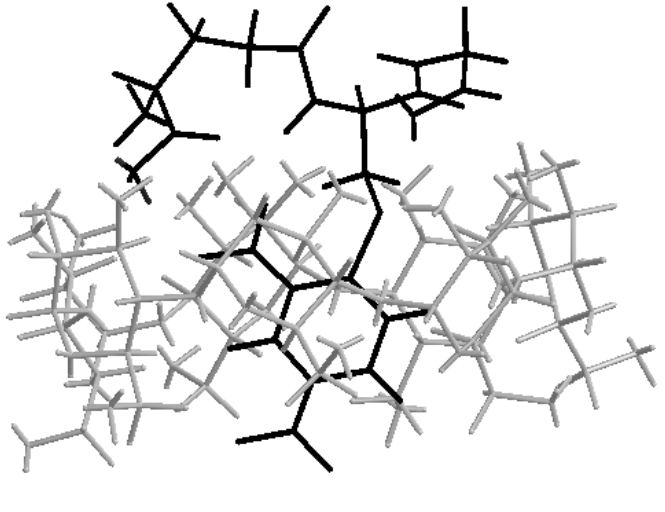
Figure 4. The energy-minimized structure of the complexes of (a) β -CD/ 3 , (b) 1 / 3 and (c) 2 / 3 . (a) β -CD/3